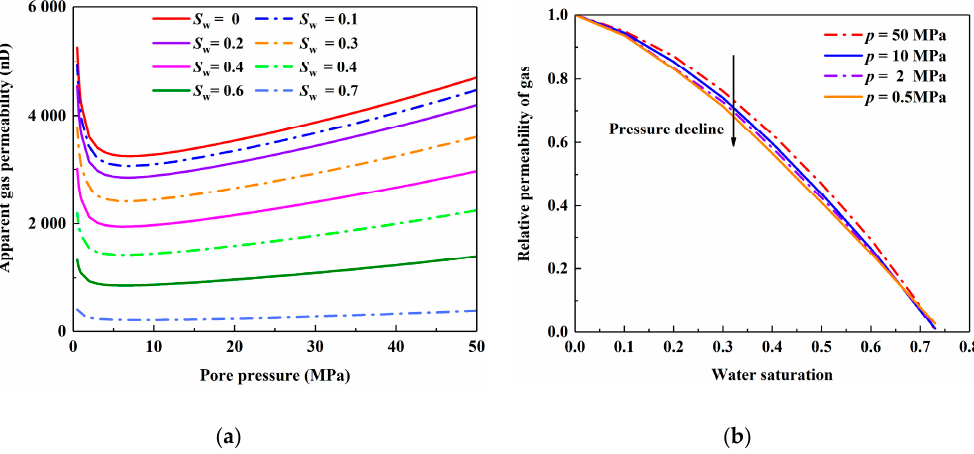
Figure 17. ( a ) The AGP and ( b ) relative permeability of shale matrix at different water saturation.